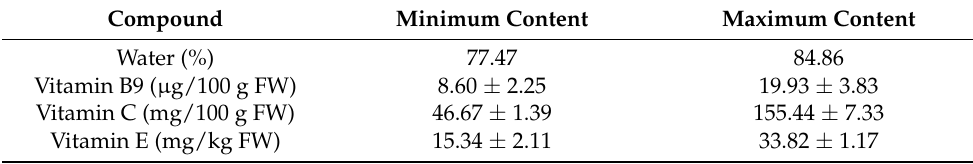
Table 2. The range of water and vitamin content among raw potato